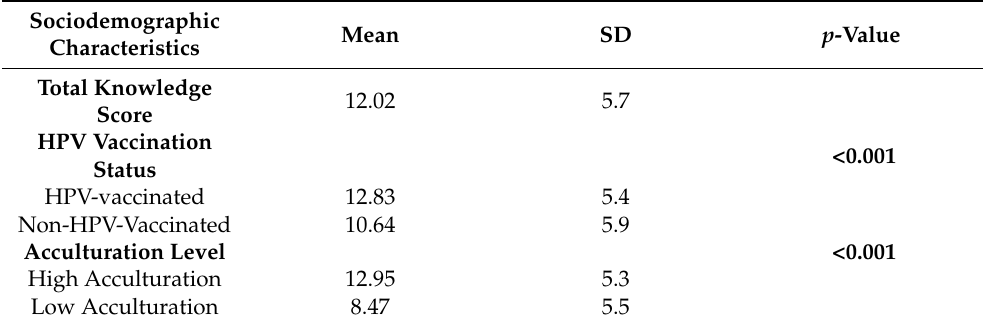
Table 5. Mean HPV and the HPV vaccine knowledge score across different HPV vaccination statuses and acculturation levels of foreign-born college students.